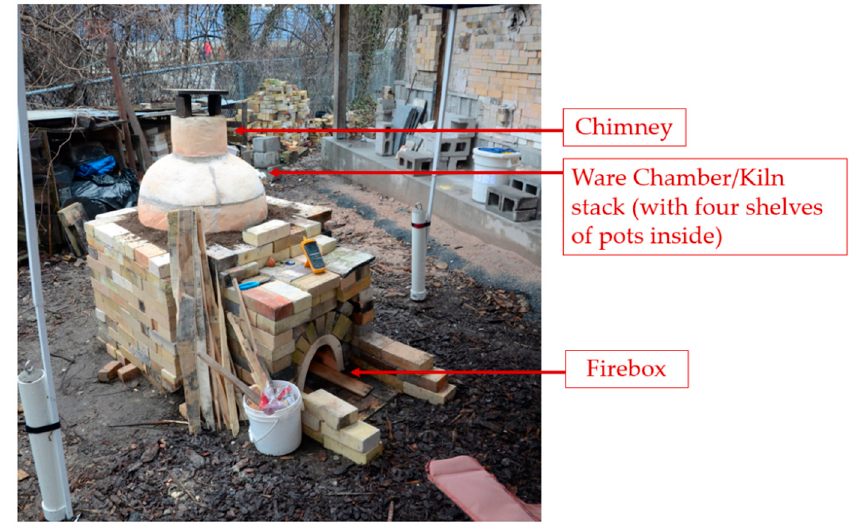
Figure 2. Kiln sited at Baltimore Clayworks. This design was based on a kiln built by Wissinger and Kahn and described in (Wissinger and Kahn 2008).